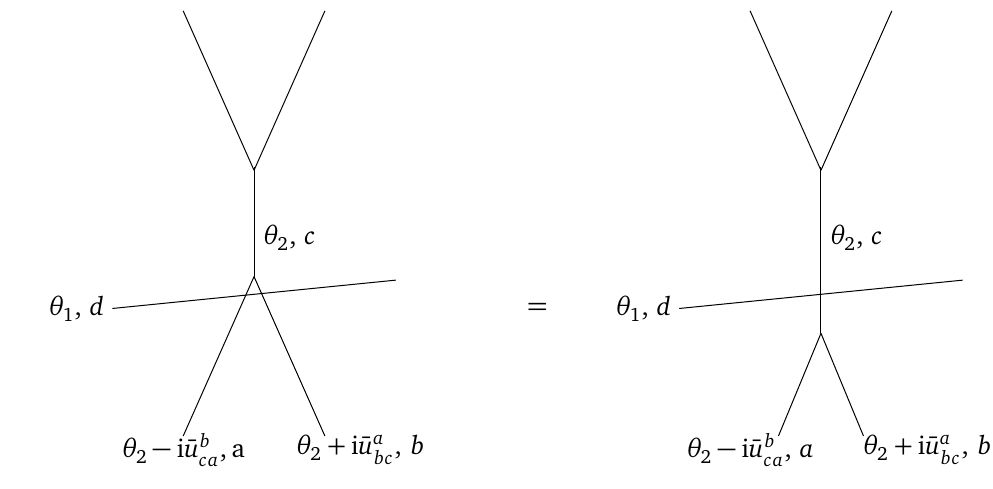
Figure 4: Bound-state bootstrap